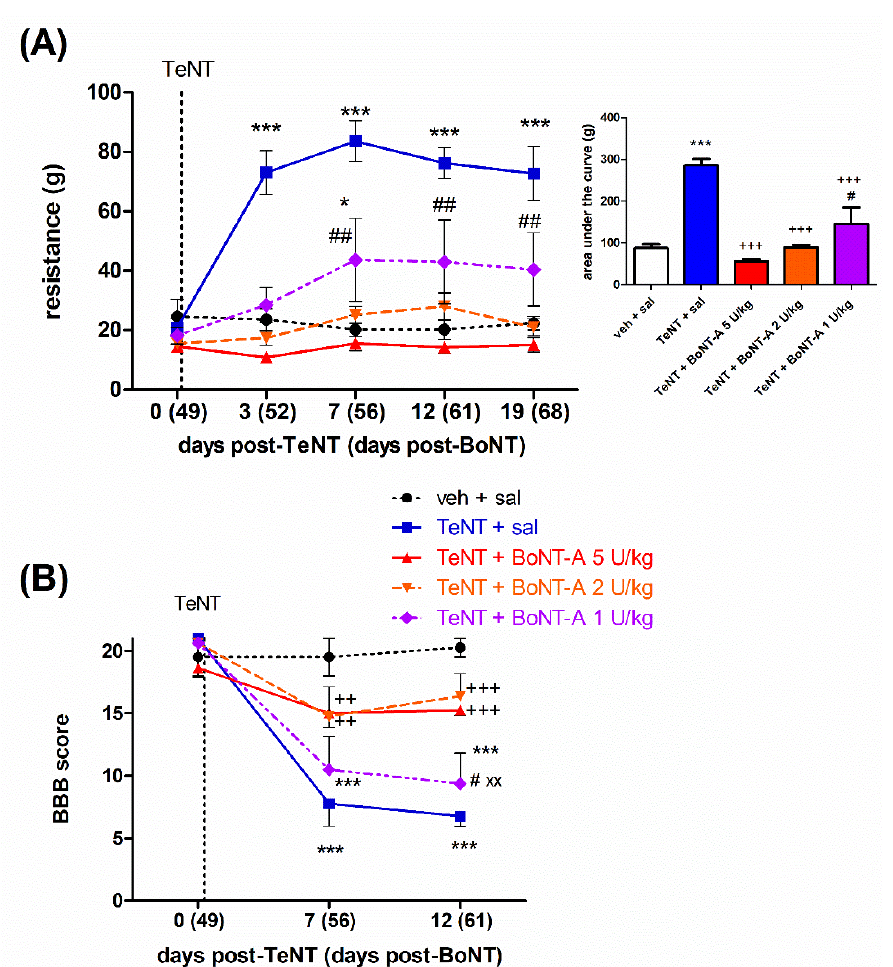
Figure 3. The late dose-dependent BoNT-A antispastic effect persists two months post-i.m. treatment. The effect of BoNT-A (1–5 U/kg) intramuscular (i.m.) injection into the gastrocnemius on a TeNT (1.5 ng, i.m.)-evoked local muscle spasm reinduced 49 days post-BoNT-A was assessed by